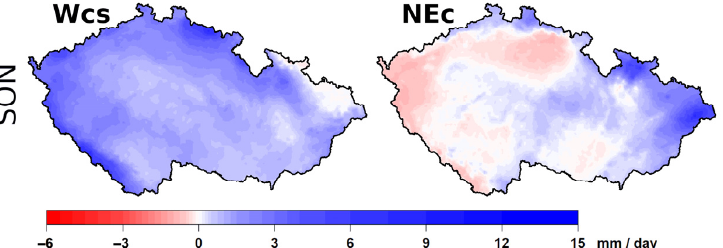
Figure 11. Anomalies of the annual and seasonal daily mean precipitation (the 1961–2020 reference period) for the circulation types under CHMI classification with the largest difference in the daily mean precipitation in favor of BOH ( left column ) and M&S ( right column ). Included types: Wc, west cyclonic; NEc, northeast cyclonic; C, cyclone over central Europe; B, trough over central Europe; Wcs, west cyclonic with southern pathway.